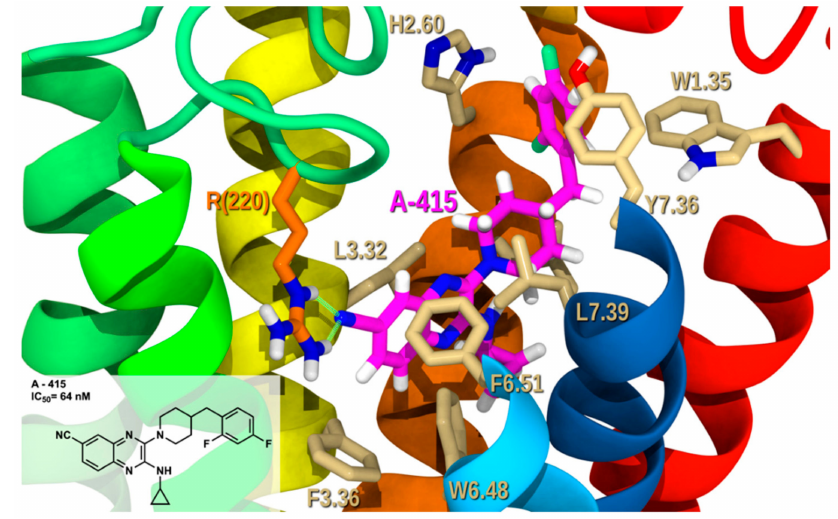
Figure 7. A-415 / GPR6 R complex. The view from the lipid bilayer with the EC portions of TMH6-7 removed for